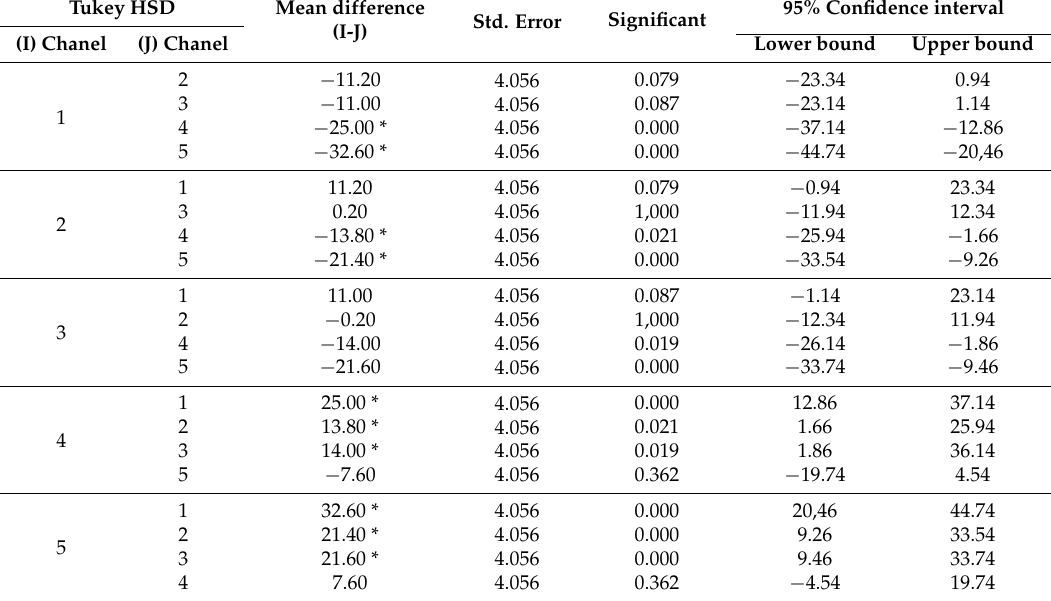
Table 3. Tukey post-test: Two significantly different groups are found: one consisting of channels 1 and 2, with lower roughness, and one with the higher roughness, channels 3, 4, and 5. Based on observed